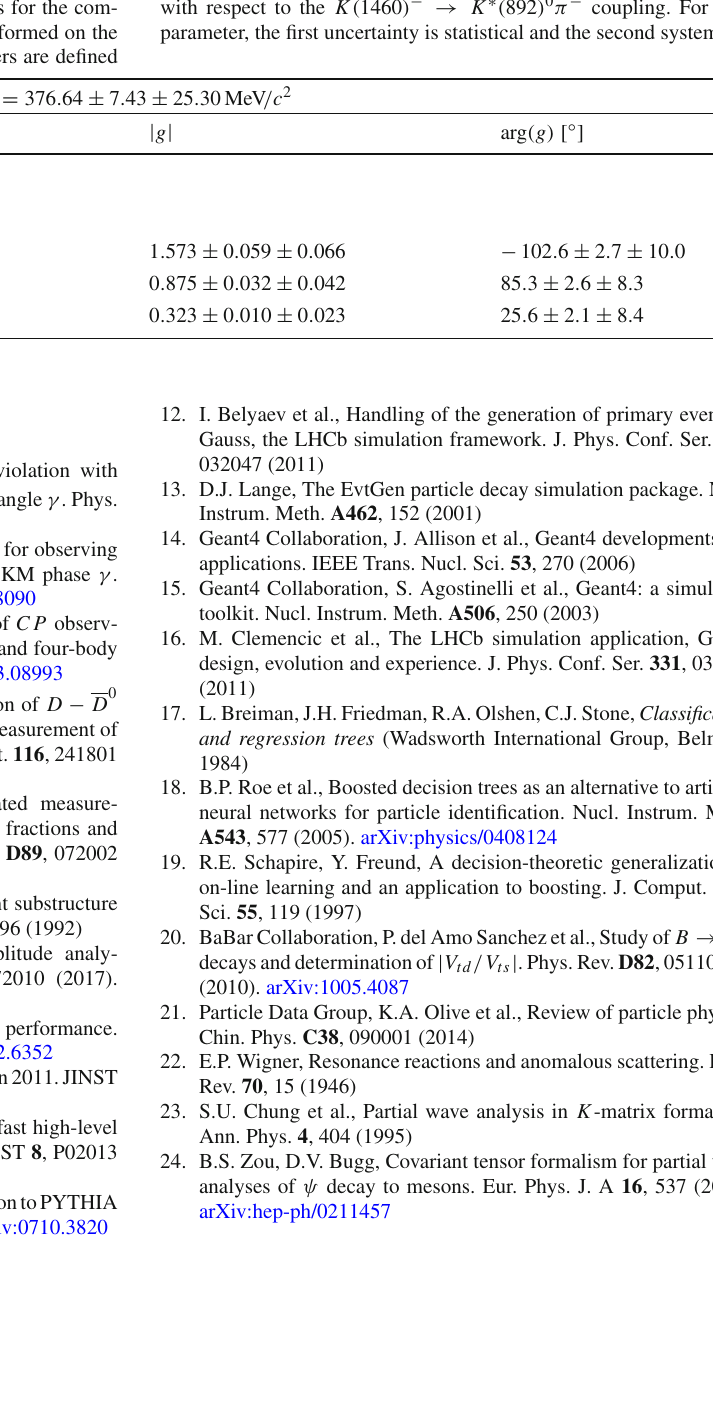
respect to the K 1 ( 1270 ) − → ρ( 770 ) 0 K − coupling. For each parame- ter, the first uncertainty is statistical and the second systematic